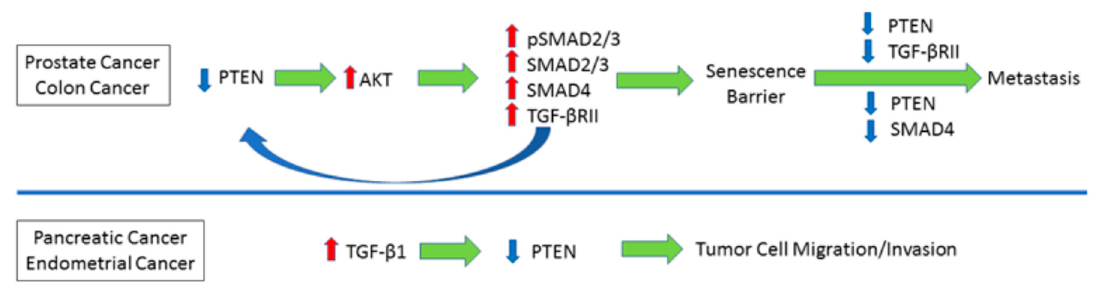
Figure 3. Extensive Cross-Talk between PTEN and TGF- β 1 in Cancer Progression. PTEN silencing, as evident during prostate cancer, promotes SMAD3, SMAD2/3 or TGF- β RII expression, establishing cancer cell senescence. Concurrent loss of either PTEN and SMAD4 or PTEN and TGF- β RII breaches this barrier against tumor progression and promoted metastasis. TGF- β 1 hyperactivation, as observed in pancreatic cancer, could downregulate PTEN via transcriptional or non-transcriptional (e.g., protein degradation) mechanisms, facilitating cancer cell invasion.